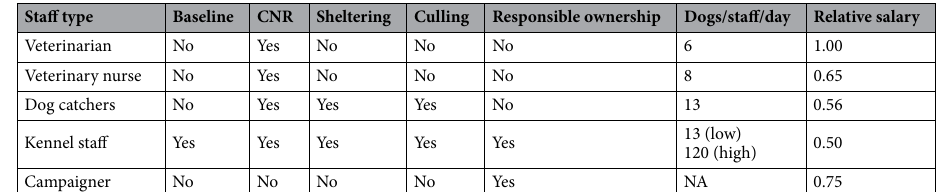
Table 3. Staff required for interventions and the number of dogs processed per staff per